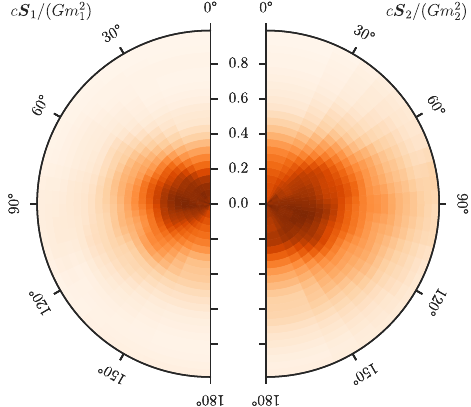
FIG. 4. Posterior probability density of BH spin directions, plotted as in Fig. 5 of Ref. [2].